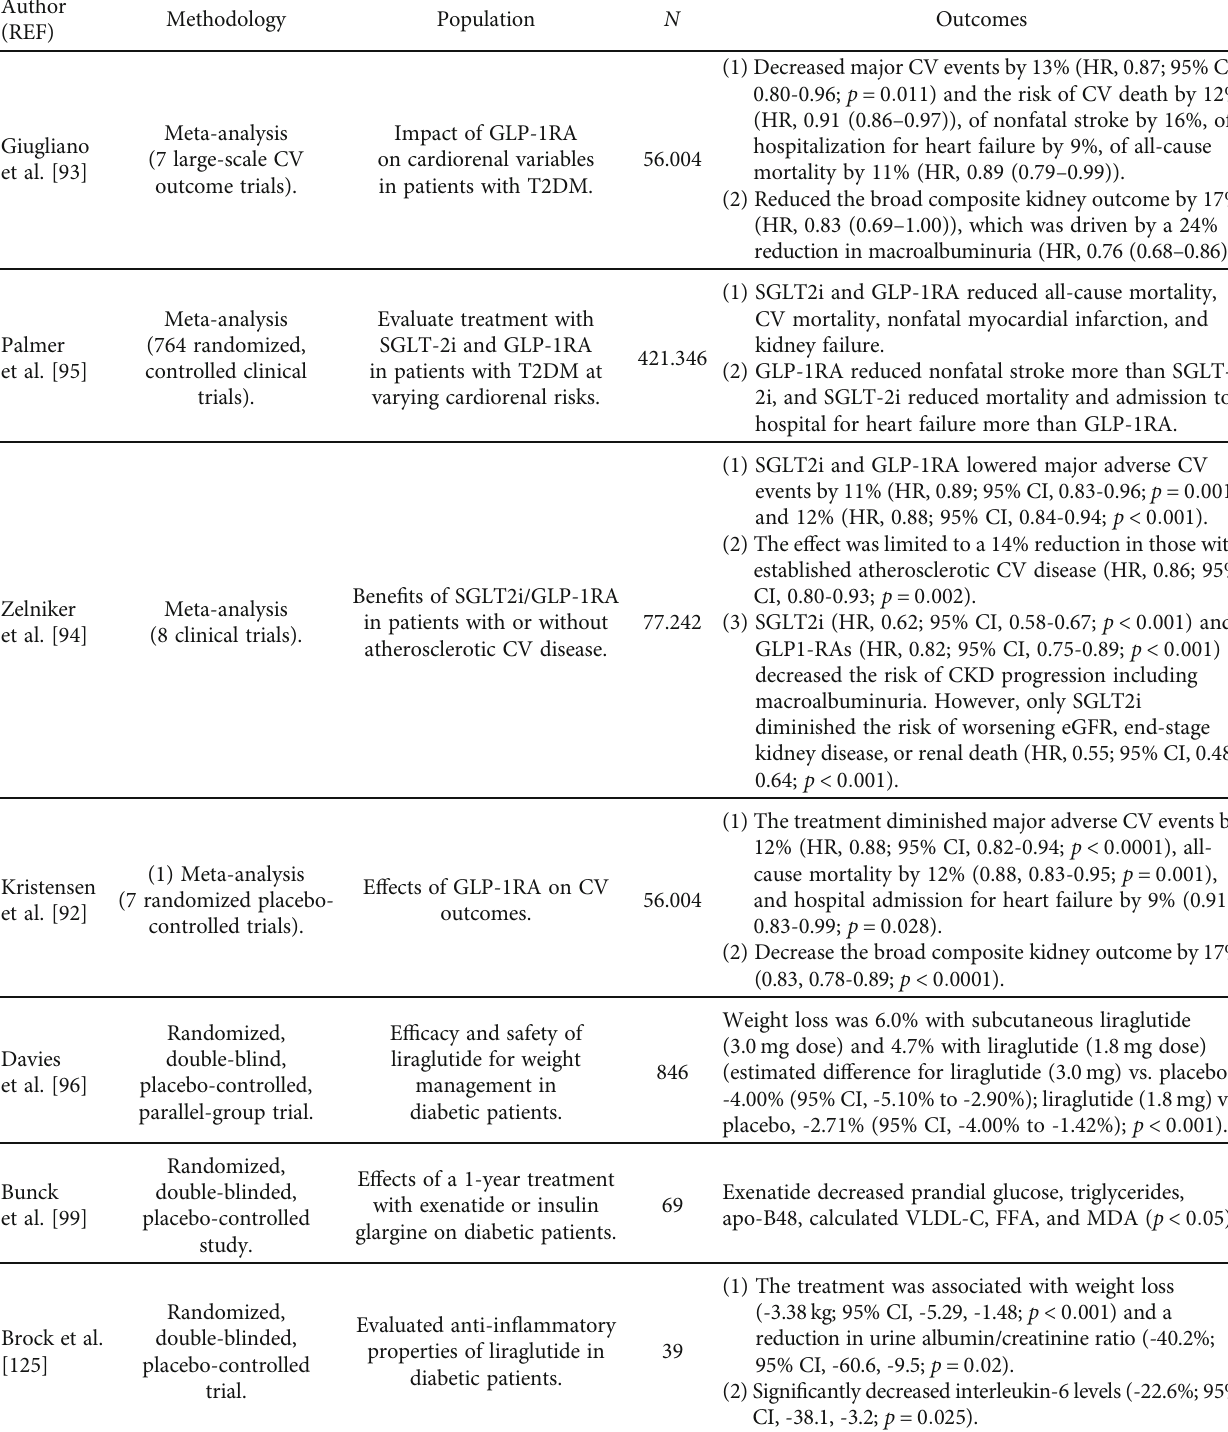
Table 2: Summary of clinical evidence regarding GLP-1RA in cardiovascular, renal, and anthropometric